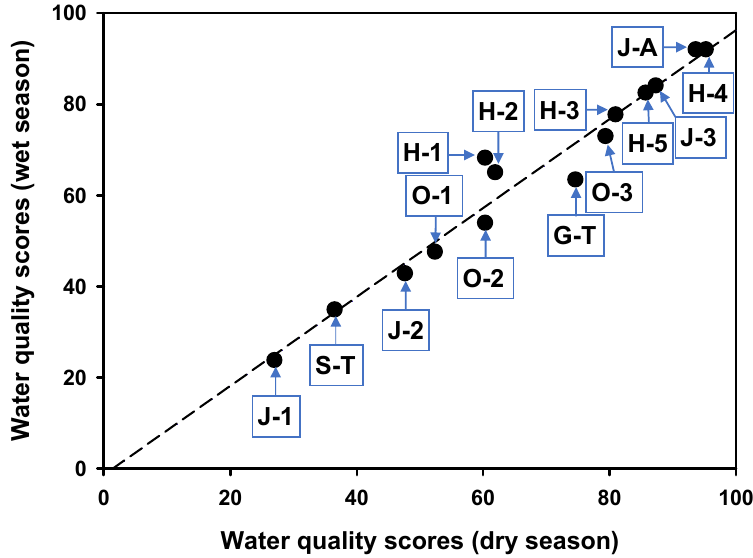
Figure 3. Results of the water quality scores during the dry and wet seasons. The RTWQI calculated the water quality index by evaluating various influencing factors on water quality (including the water temperature and EC), rather than the water quality score. The scores were classified into five grades and are displayed on the map (Figure 4). The RTWQI ranged from 51 to 93 in the dry season, and 53 to 93 in the wet season. The majority of the upstream sites (H-2, O-2, J-2, and S-T) had a higher water quality score during the wet season when compared to the dry season. This result indicates lower pollution levels, mainly due to the dilution effect of wet season rainfall. However, at the G-T site (which is on a stream flowing into the downstream Jinwi River), the average SS and T-P values were higher in the wet season than in the dry season (Table S5), and the TOC temporarily increased in the rainy season, causing many outliers in our data. Therefore, G-T experienced an increase in the SS and T-P, which was introduced from non-point source pollution, or from local runoff, rather than from the dilution effects from an increase in the flow rate during the rainy season.